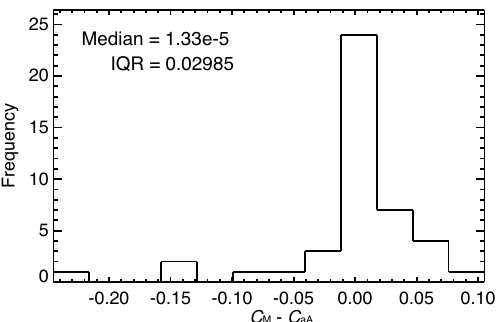
Figure 12. Difference in domain-averaged cloud cover based on the operational MODIS cloud mask ( C M ) and co-located ASTER observations ( C aA ). Values for the median and interquartile range (IQR) are